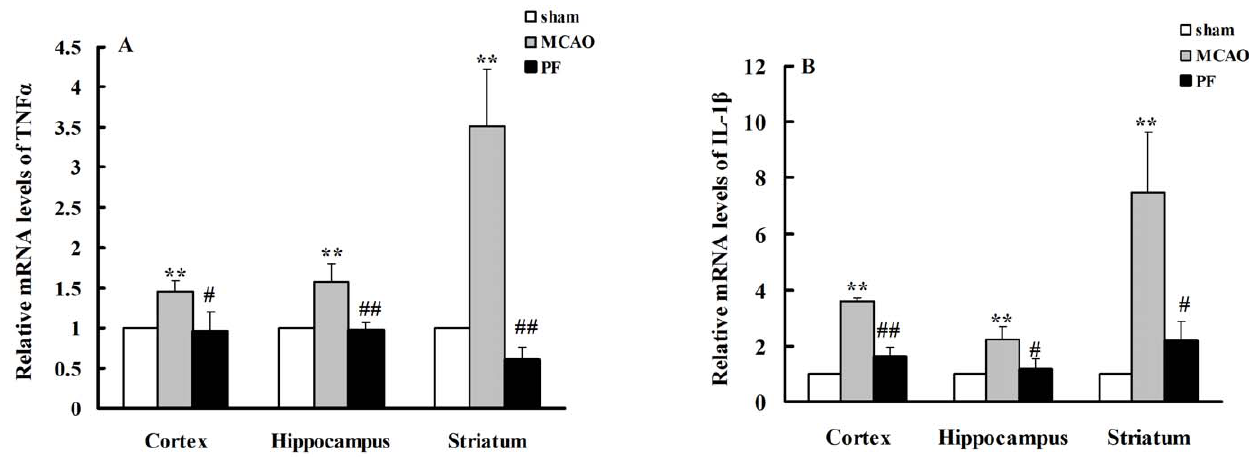
Figure 5. PF treatment decreases the mRNA expressions of TNF a (A) and IL-1 b (B) in the brain. Sham, rats received surgery without vessel occlusion; MCAO, rats treated with saline for 14 days after transient MCAO; PF, PF (5 mg. kg 2 1 ) was administered for 14 days after MCAO; n=4. All data were expressed as mean 6 SD. ** P , 0.01 vs sham, # P , 0.05; ## P , 0.01 vs MCAO.